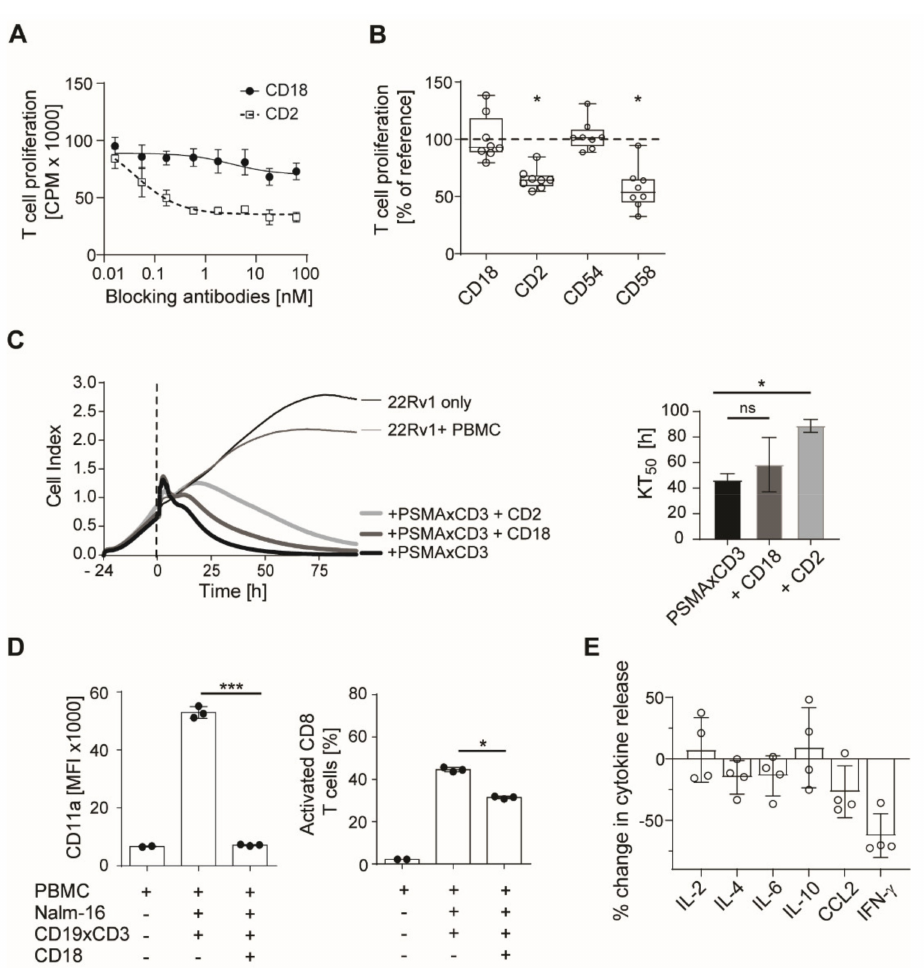
Figure 5. Effects of blocking antibodies on on-target activation. ( A ) On-target T cell activation was measured in a 3 day 3H-thymidine incorporation assay using 100,000 PBMC, 100,000 CD19+ Nalm-16 cells and a CD19xCD3 antibody at 5 nM and ascending doses of CD2 and CD18 blocking antibodies. Representative results from experiments with three donors (mean ± SD from triplicates). ( B ) On-target activation as described in A ( n = 8, boxplots with min/max whiskers, unpaired t -test). Activation with 100,000 PBMC, 100,000 CD19+ Nalm-16 cells and a CD19xCD3 antibody at 5 nM was set to 100%. ( C ) Real-time tumor cell lysis using xCELLigence. 24 h after addition of PSMA+ 22Rv1 cells, PBMCs and PSMAxCD3 antibodies at 1 µ g/mL were added. Cell indices correspond to the number of viable 22Rv1 tumor cells. The graph represents the mean of three independent experiments. A Killing Time (KT50) corresponding to the time required to kill 50% of 22Rv1 target cells are presented in the table. ND. not detected. ( D ) Flow cytometric analysis of CD11a and CD69 expression upon on-target stimulation as described in A ( n = 3, mean ± SD, unpaired t -test). ( E ) Cytokine release during on-target activation analyzed by LEGENDplex analysis ( n = 4, bars depicting mean ± SD, Mann–Whitney U test) utilizing supernatants from assays as described in A . * p < 0.05, *** p <